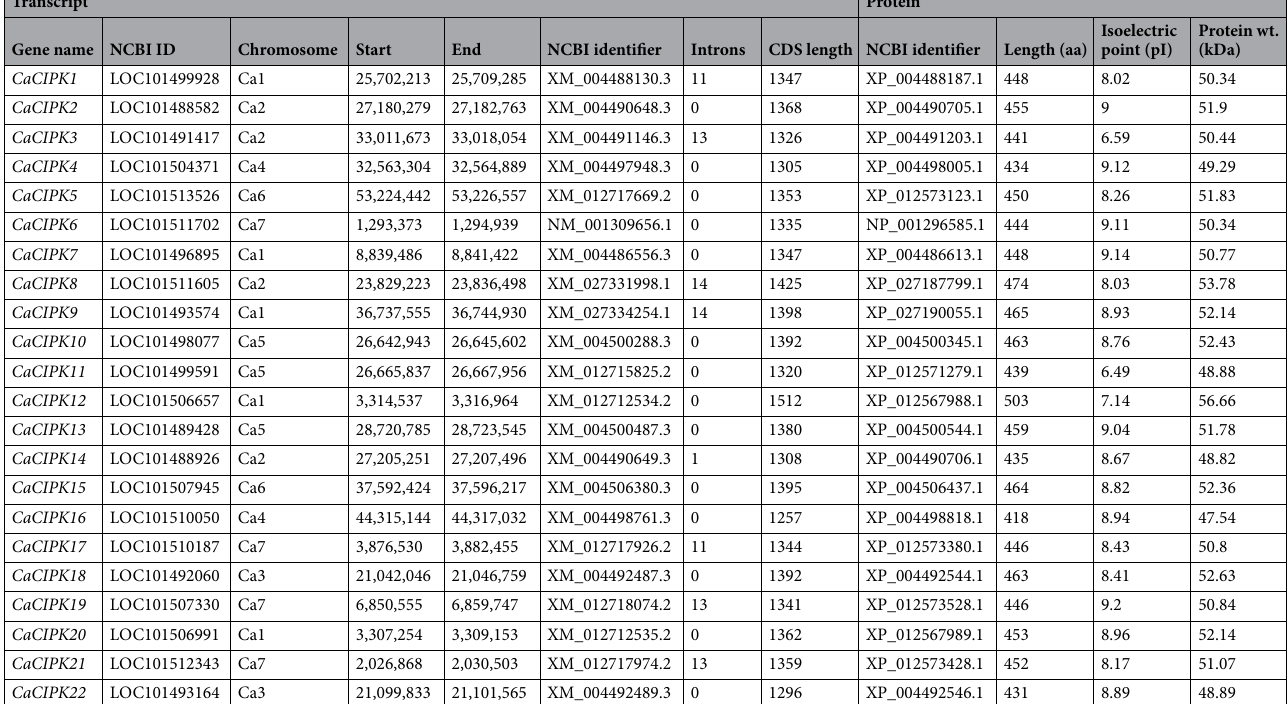
Table 1. Summary of various features of the chickpea CIPK family.